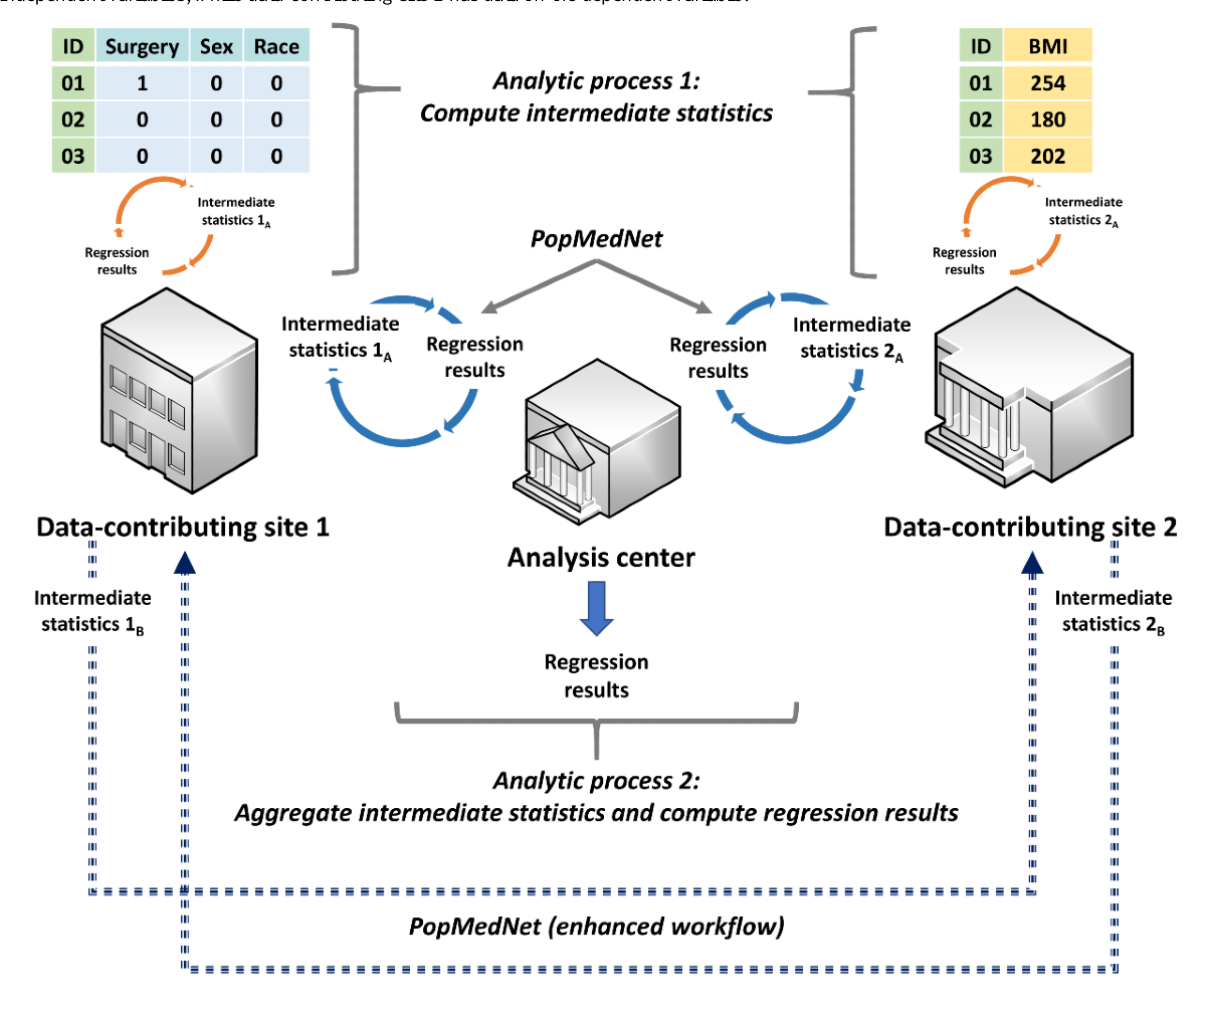
Figure 5. Enhanced PopMedNet workflow to enable automatable distributed regression analysis in vertically partitioned data environments. In this hypothetical example, surgery, sex, and race are the independent variables, while BMI is the dependent variable. Data-contributing site 1 has data on the independent variables, while data-contributing site 2 has data on the dependent